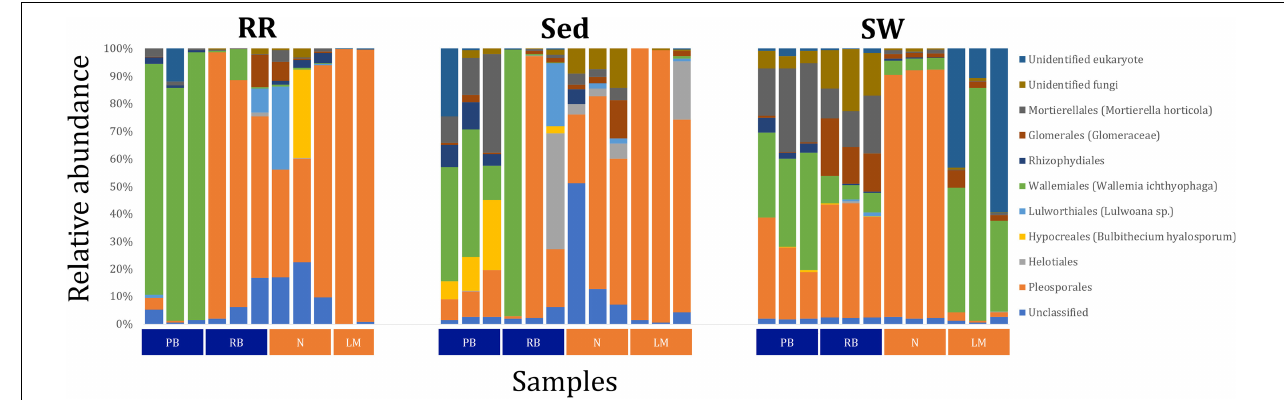
FIGURE 11 | Fungal community composition across seagrass microenvironments. Beta diversity of fungal microbiomes across the three seagrass microenvironments studied here. Triplicate samples per microenvironment within each of the four sampling sites ( n = 35) are colored by the highest assigned taxonomic level. Unique OTUs were summarized at the species level, and the representation of taxonomic groups within each sample are plotted. Only representative species with a relative abundance > 1% in all samples are shown to help remove visual clutter. RR, roots and rhizomes; Sed, sediment; SW,